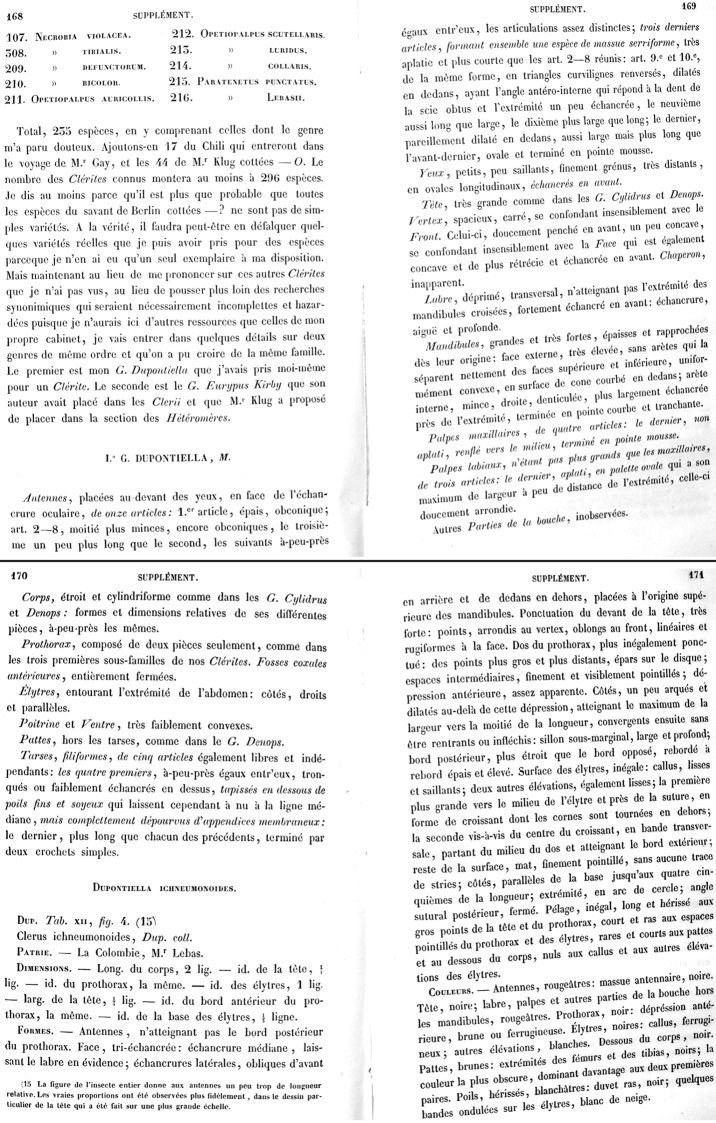
A facsimile of Spinola 1844: 168–171. The original descriptions of the genus Dupontiella and the species Dupontiella ichneumonoides.